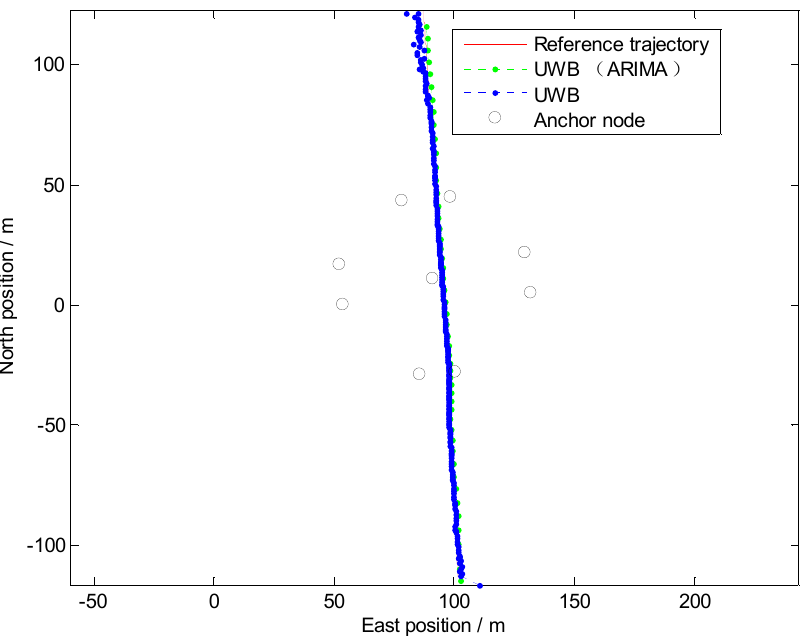
Figure 7. Positioning results in Trajectory I (Straight Line).